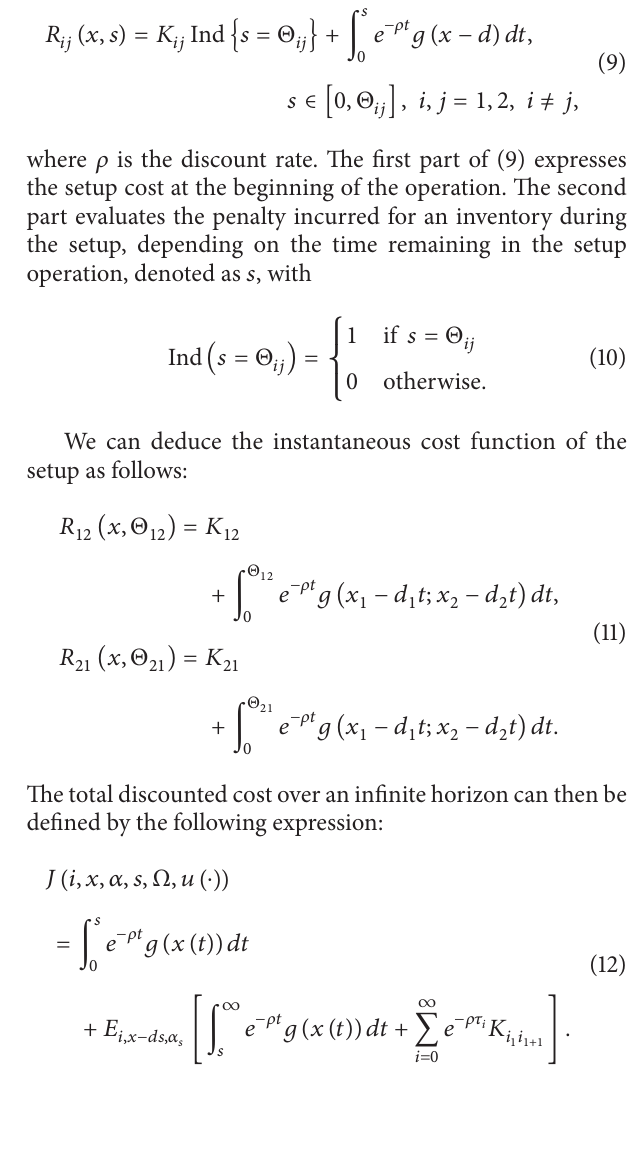
transition diagram of the Markov chain associated with the machine dynamics is shown in Figure